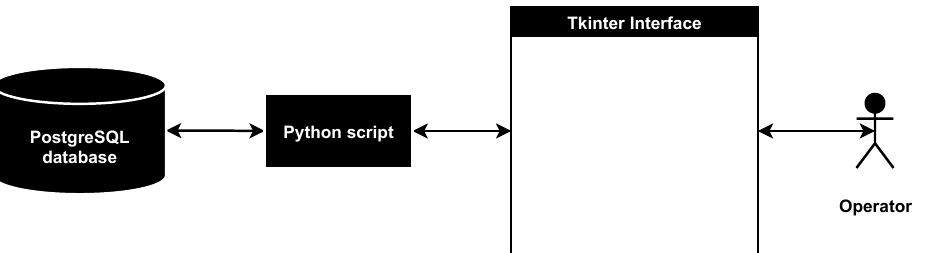
Figure 5. The architecture of the software